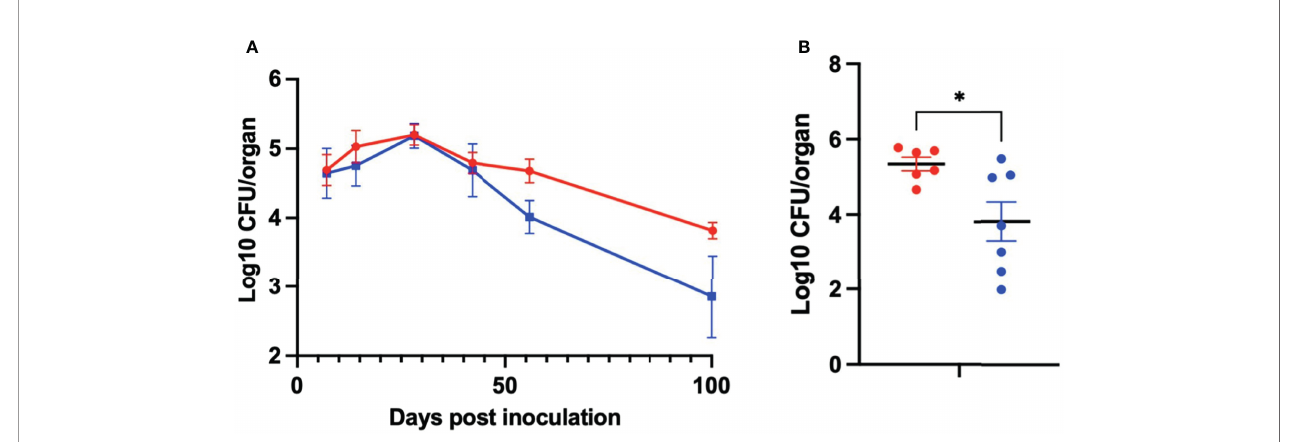
FIGURE 5 | PsxA contributes to persistence of B. pseudohinzii in the middle ears. (A) Log10 of CFU of WT B. pseudohinzii (red) or B. pseudohinzzi D psxA (blue) recovered from the middle ears of C57BL/6 mice on days 7, 14, 28, 42, 56, and 100 post inoculation (n=4 per strain and timepoint). (B) Log10 of CFU isolated from the middle ears of C57BL/6 mice on day 56 post inoculation (WT B. pseudohinzii n=6 and B pseudohinzii D psxA n=7). Error bar shows standard error of mean. Statistical signi fi cance was calculated via Two-way ANOVA. *p<0.0332.